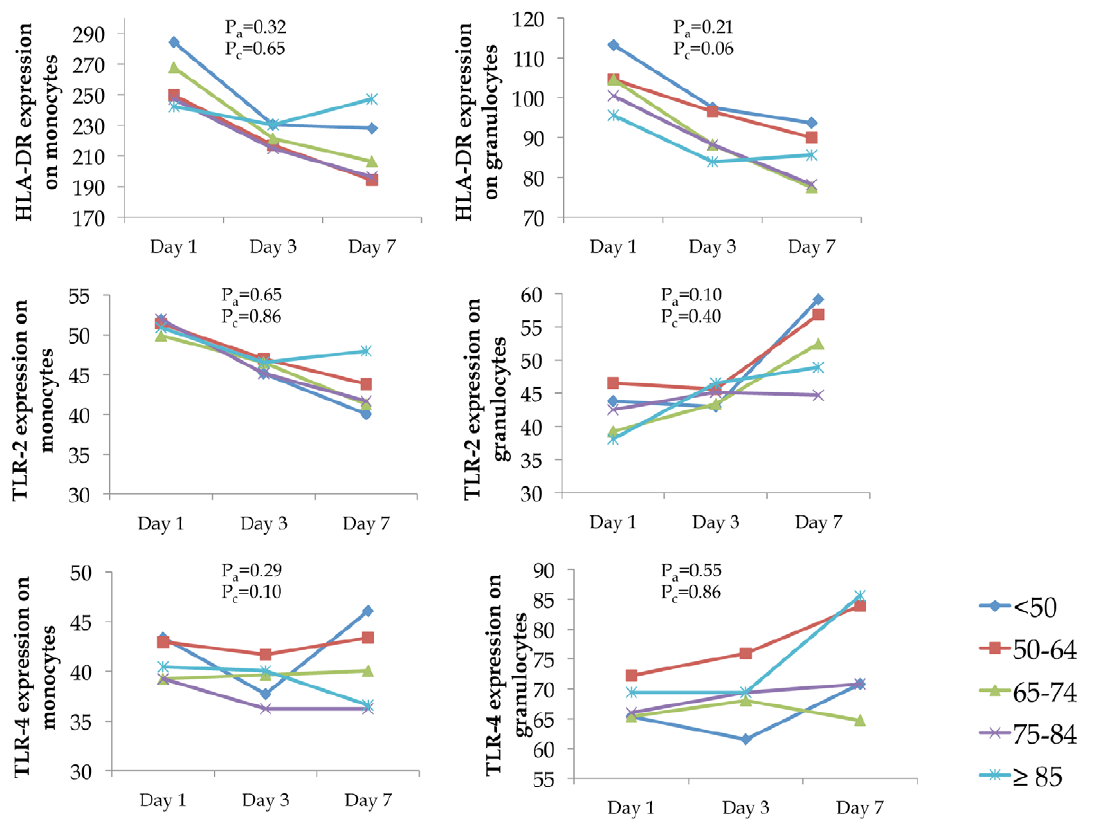
Figure 3. No differences were found in expression of cell surface markers when stratified by age group. Markers were measured upon ED presentation and at days 3 and 7. Values for cell surface markers are reported as mean channel fluorescence (MCF) of cells positive for a given cell surface marker. Pa are p values from ANOVA models adjusted for sex, race, comorbidity, and smoking status to compare differences in mean levels of markers on Day 1 across different age groups. Pc are p values from mixed effects model adjusted for sex, race, comorbidity, and smoking status to compare mean levels on Days 1, 3, and 7.